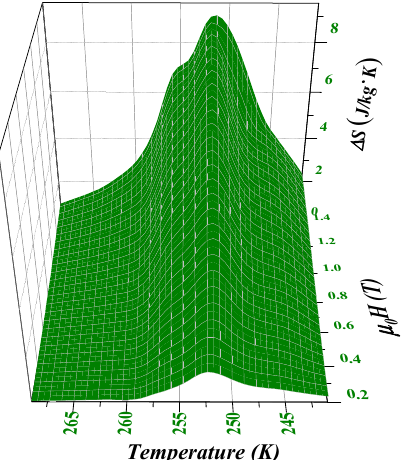
Figure 9. 3D curve of the temperature, magnetic field, and maximum isothermal magnetic entropy variation of the LaFe 11.5 Si 1.5 C 0.2 fast quenched band at 35 m/s (after 1273 K × 2 h heat treatment) .